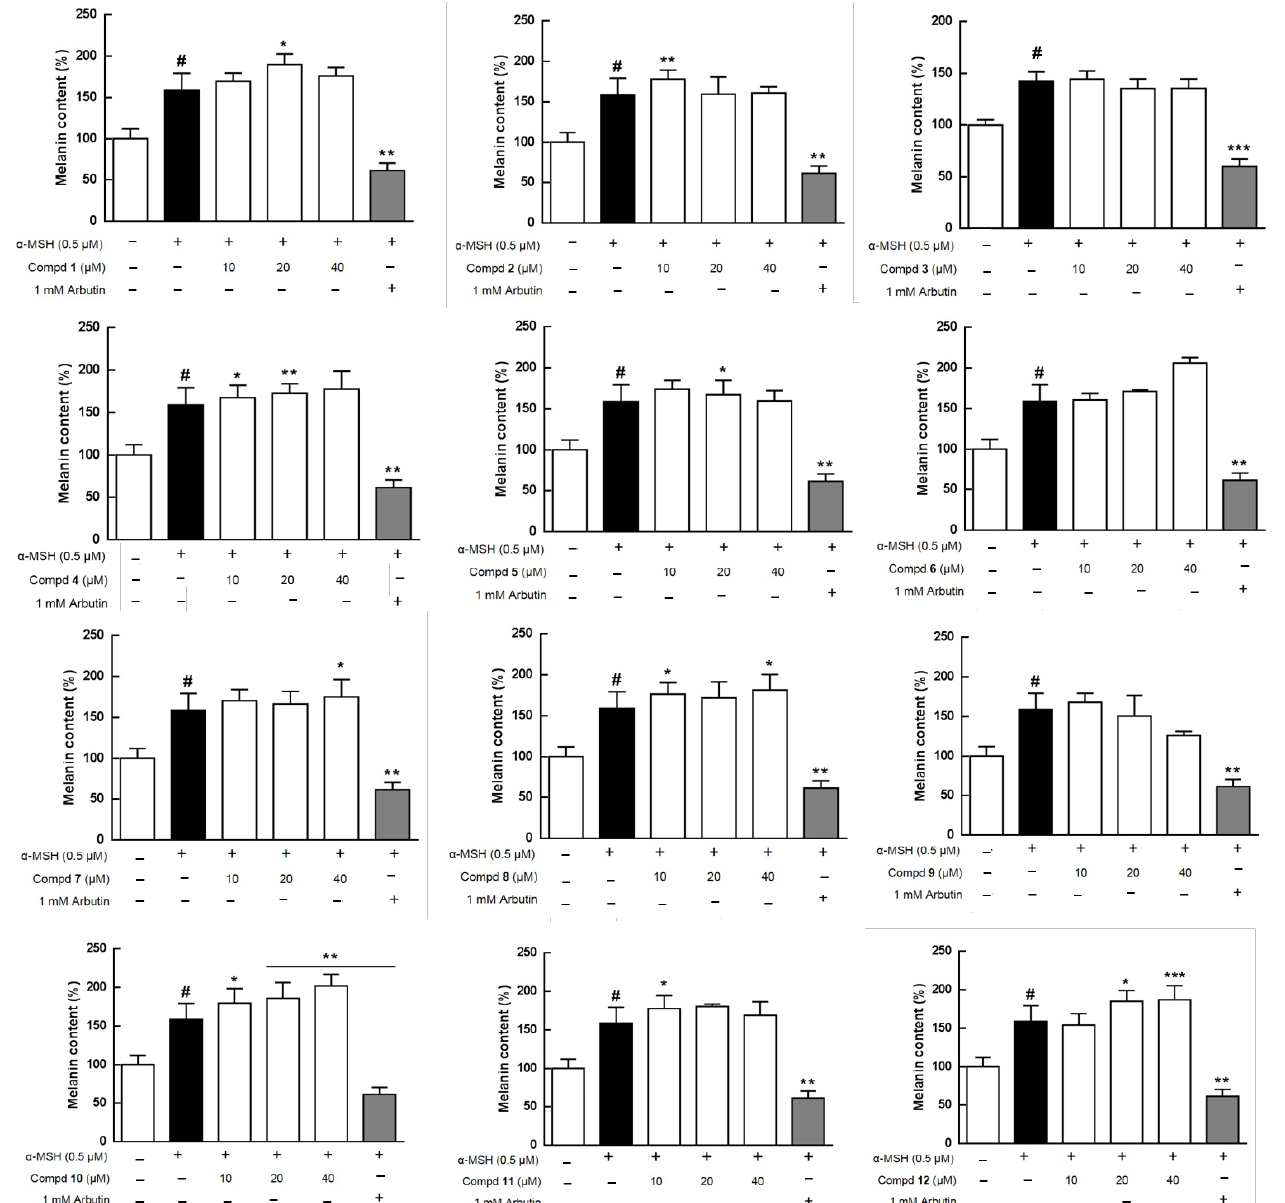
Figure 4. Regulation of melanogenesis effects of compounds 1 – 12 . The data are representative of three independent experiments. #, p < 0.05 compared with the control group; *, p < 0.05, **, p < 0.01, and ***, p < 0.001 compared with the α -MSH-treated group.